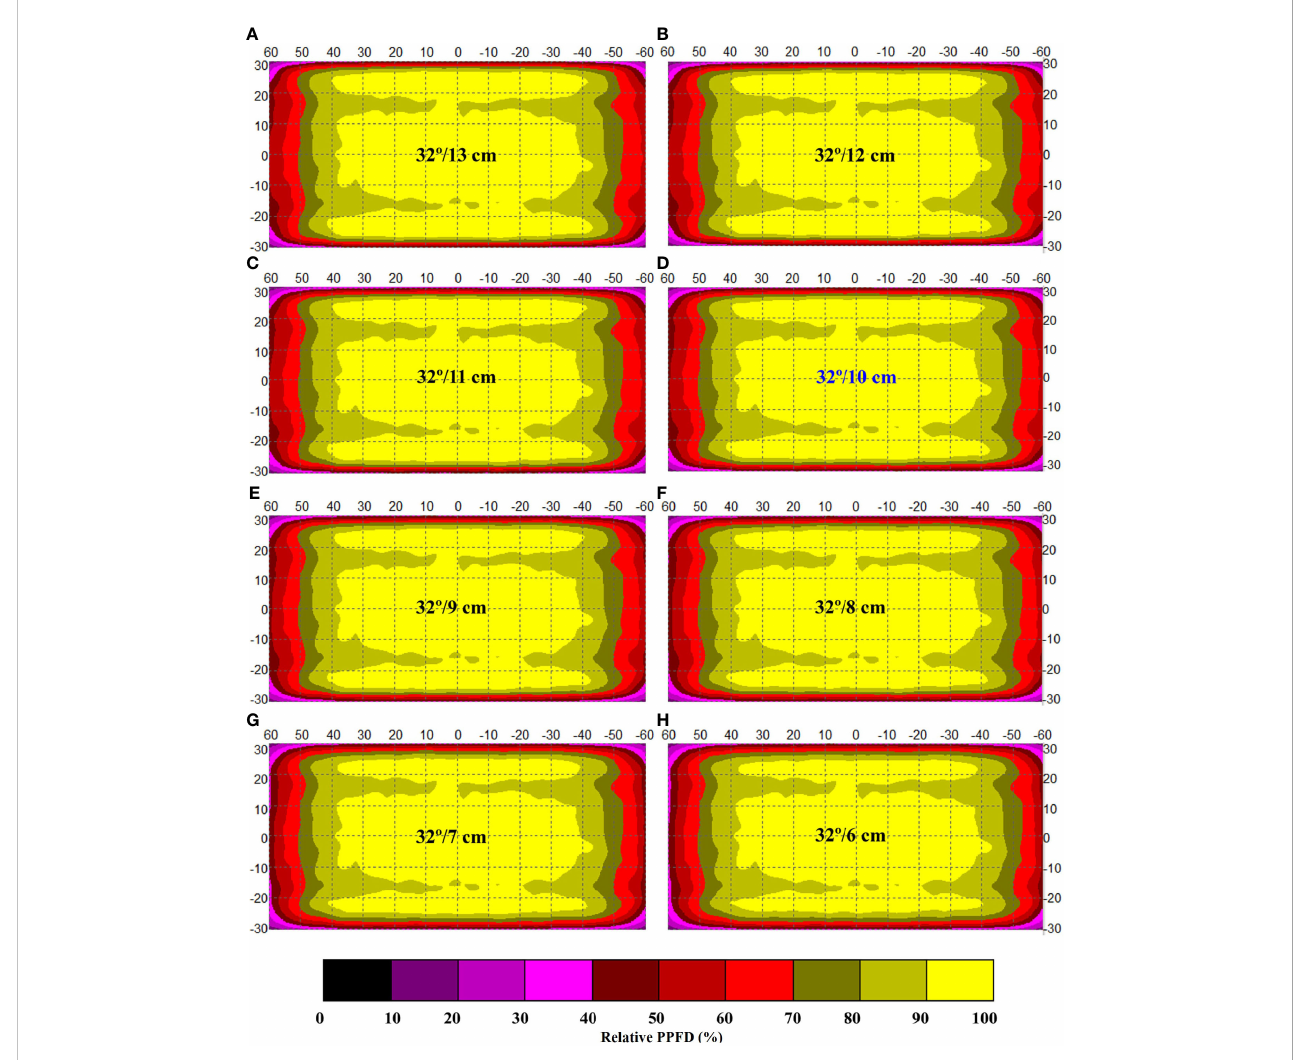
FIGURE 5 Screening of the appropriate width of the re fl ective board under the optimal included angle (32°) for the optimization of simulated light intensity distribution along an indoor farm rack shelf with the application of an adjustable lampshade-type re fl ector. The screened widths are (A) 13 cm, (B) 12 cm, (C) 11 cm, (D) 10 cm, (E) 9 cm, (F) 8 cm, (G) 7 cm, and (H) 6 cm, respectively. The scale unit on the fi gure is centimeter. The numbers in the color bar indicate relative photosynthetic photon fl ux density values